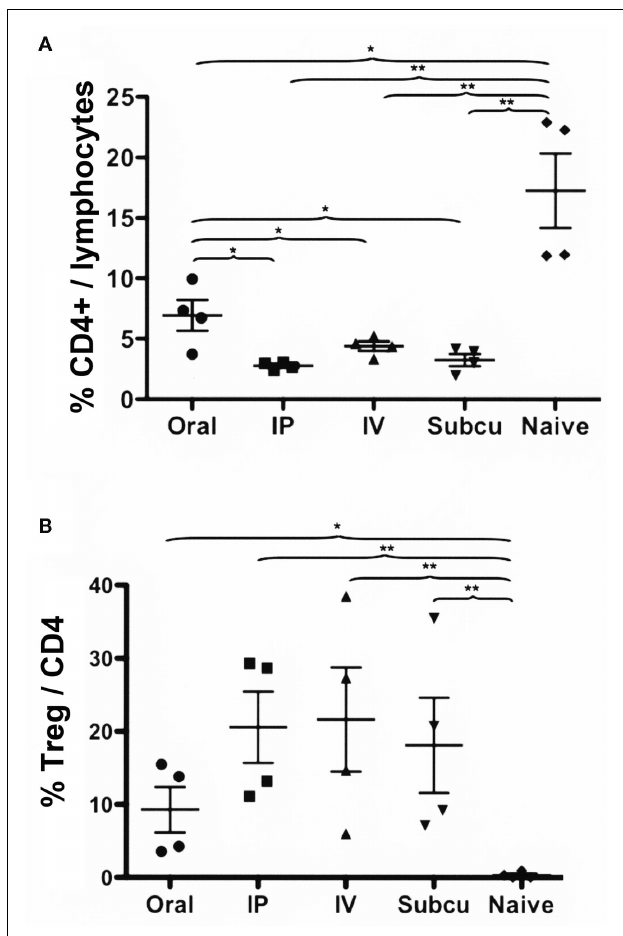
FIGURE 3 | Comparison of Rapa/IL-10/specific peptide tolerization protocol using different routes of drug administration. DO.11.10-tg Rag − / − mice ( n = 4/group) were treated for 3weeks with Rapa/IL-10/ova-specific peptide, after which the spleens were harvested, and flow cytometry was used to determine: (A) percentage of CD4 + T cells of total gated splenocytes and (B) percentage of CD25 + FoxP3 + cells of CD4 + T cells. Statistically significant differences between two groups are indicated as * P < 0.05 and ** P < 0.01.